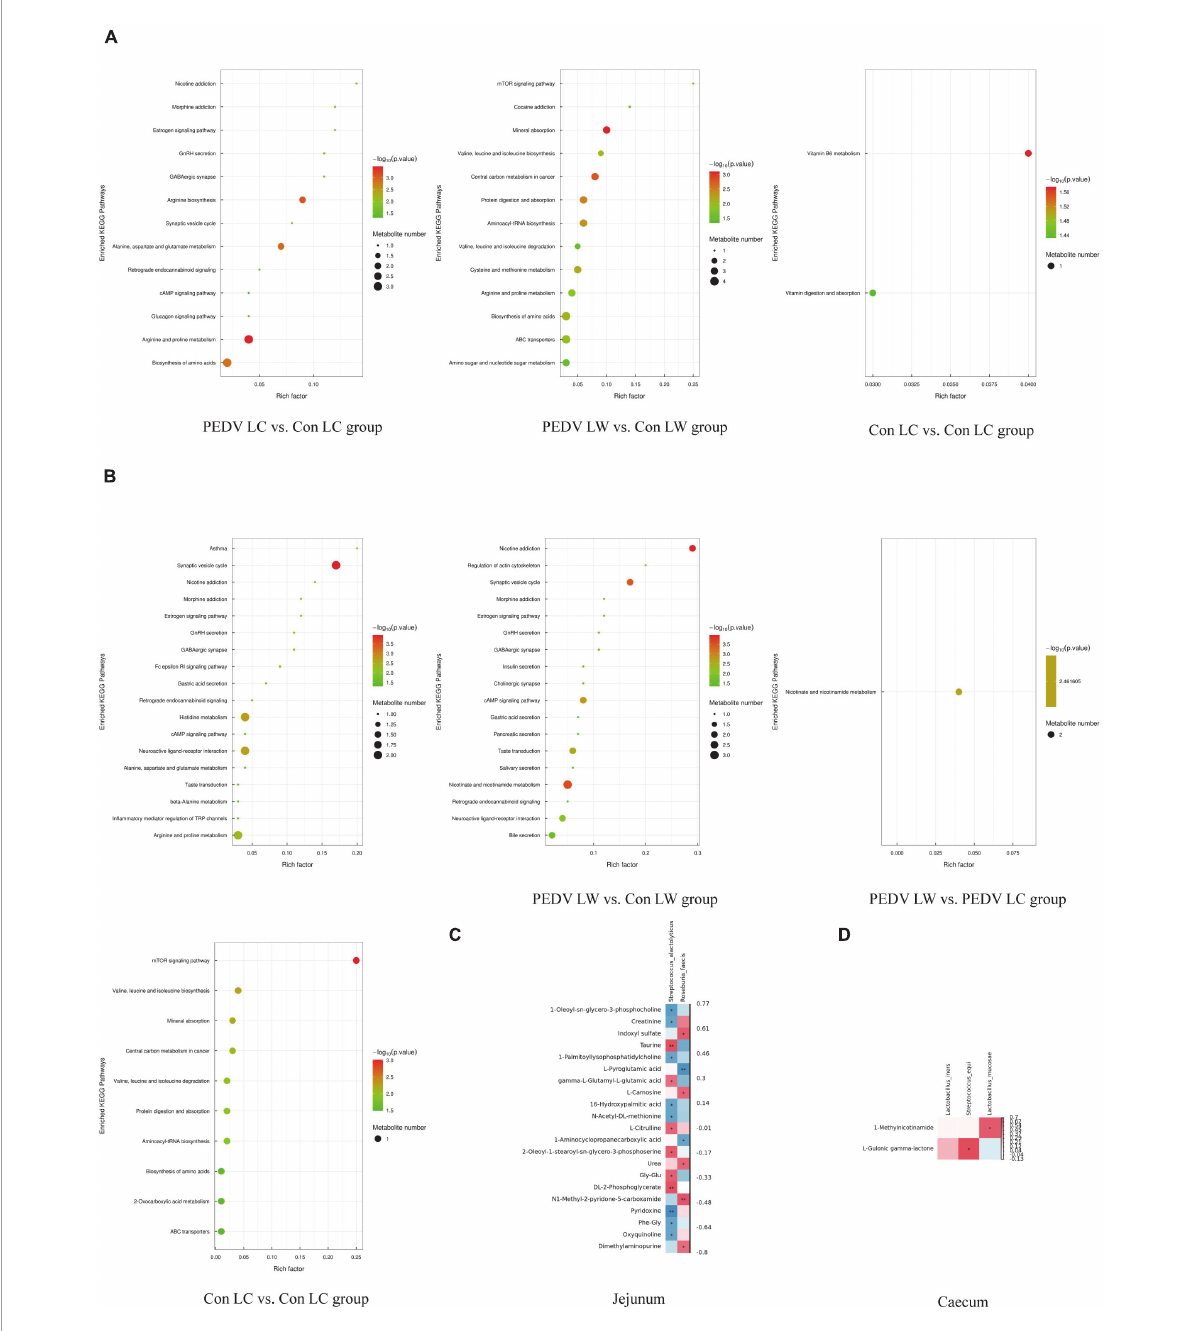
FIGURE5 (A) KEGG enrichment pathway of different metabolites in jejunum. (B) KEGG enrichment pathway of different metabolites in cecum. (C) Spearman correlation analysis of different microorganisms and metabolites in the jejunum. (D) Spearman correlation analysis of different microorganisms and metabolites in the